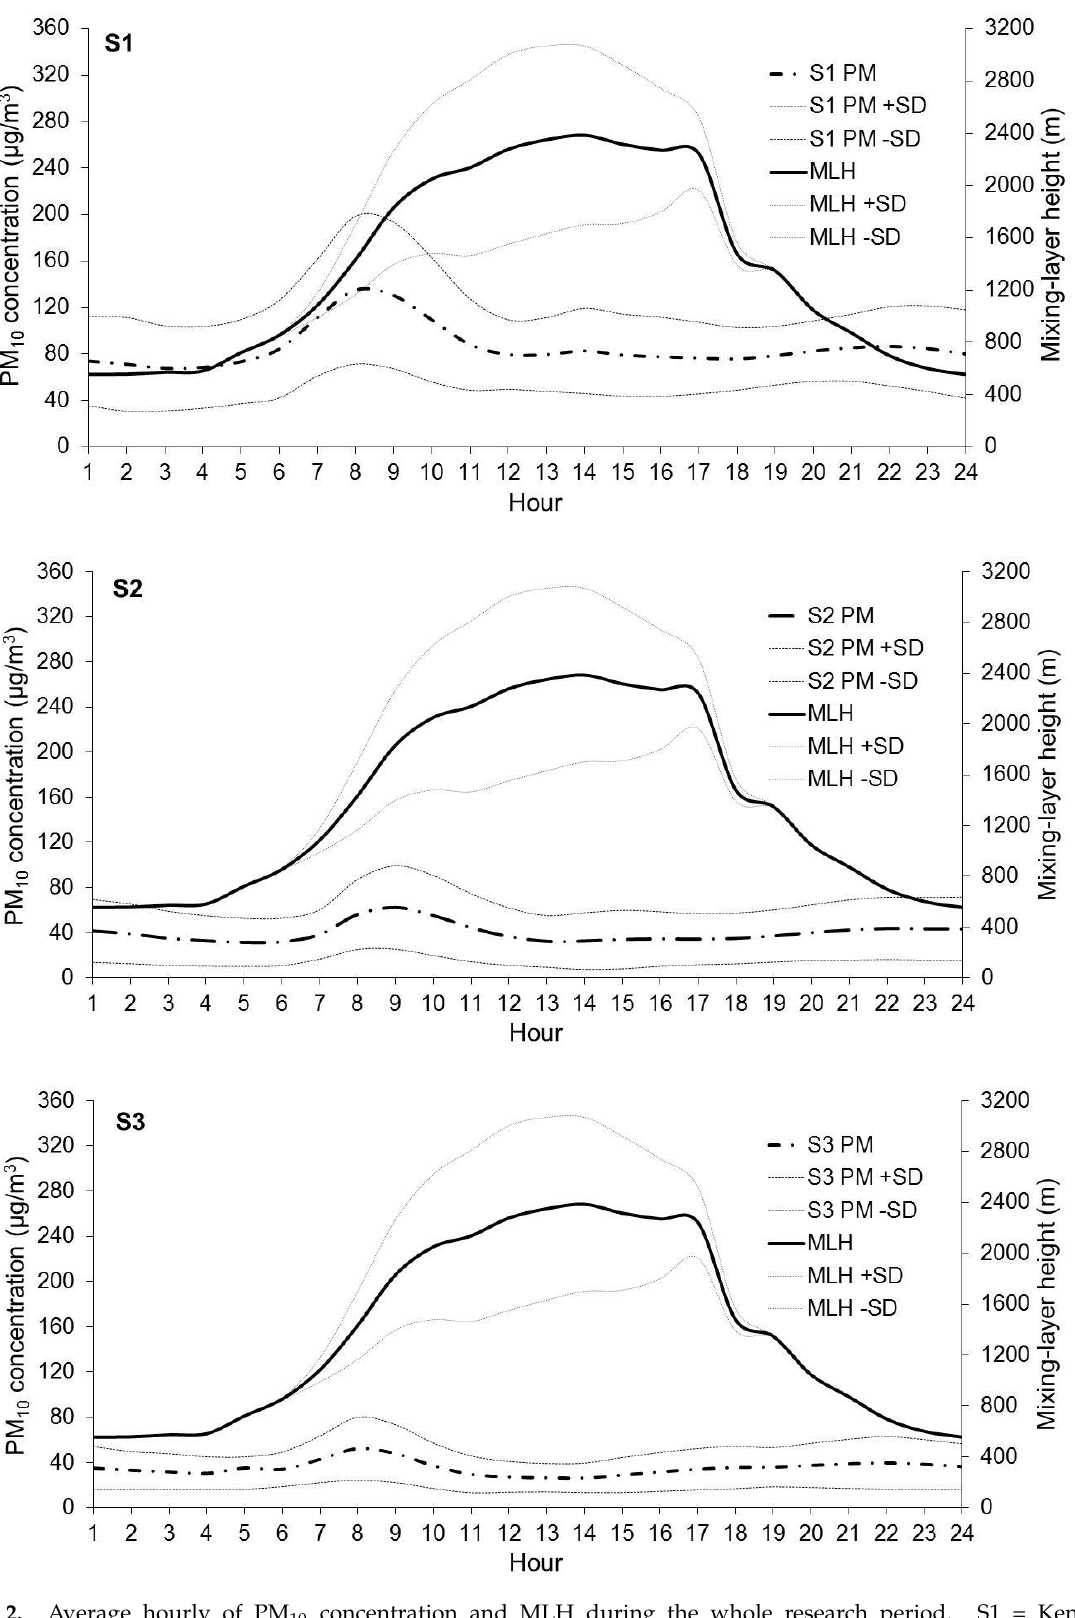
Figure 2. Average hourly of PM 10 concentration and MLH during the whole research period. S1 = Kennedy, S2 = Barrios Unidos, and S3 = Suba. PM = average hourly PM 10 concentration. MLH = average hourly mixing-layer height. SD = standard